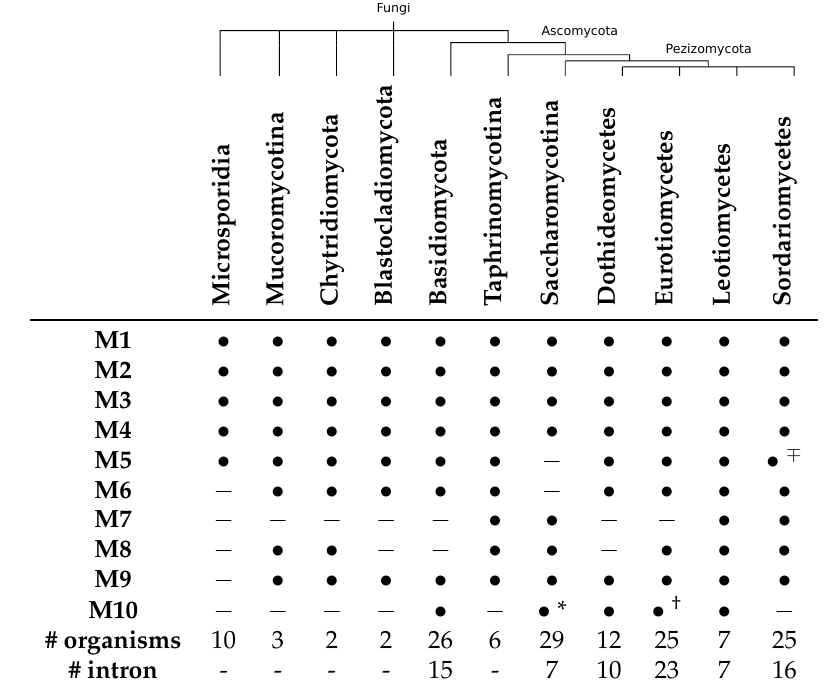
Table 1. Variation of U3 snoRNA secondary structures across the major fungal lineages.